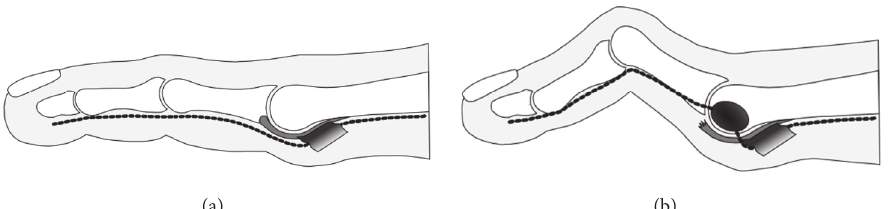
Figure 4: Diagram showing the etiology of interdigital neuroma associated with metatarsophalangeal joint instability. (a) The interdigital nerve runs consistently along the bottom side of the toe passing under the deep transverse metatarsal ligament at the distal metatarsal. (b) Metatarsophalangeal joint instability can curve the interdigital nerve with the distal end of deep transverse metatarsal ligament as a flexion point predisposing the nerve to impingement by the adjacent metatarsal